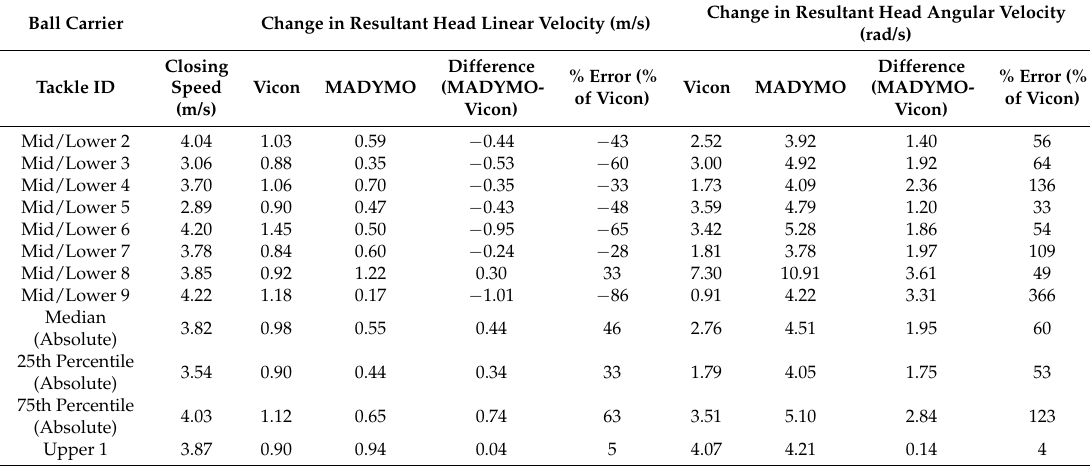
Table 1. The ball carrier change in head linear and angular velocity multibody model predictions (MADYMO) with 3D motion laboratory measures (Vicon) with absolute and percentage